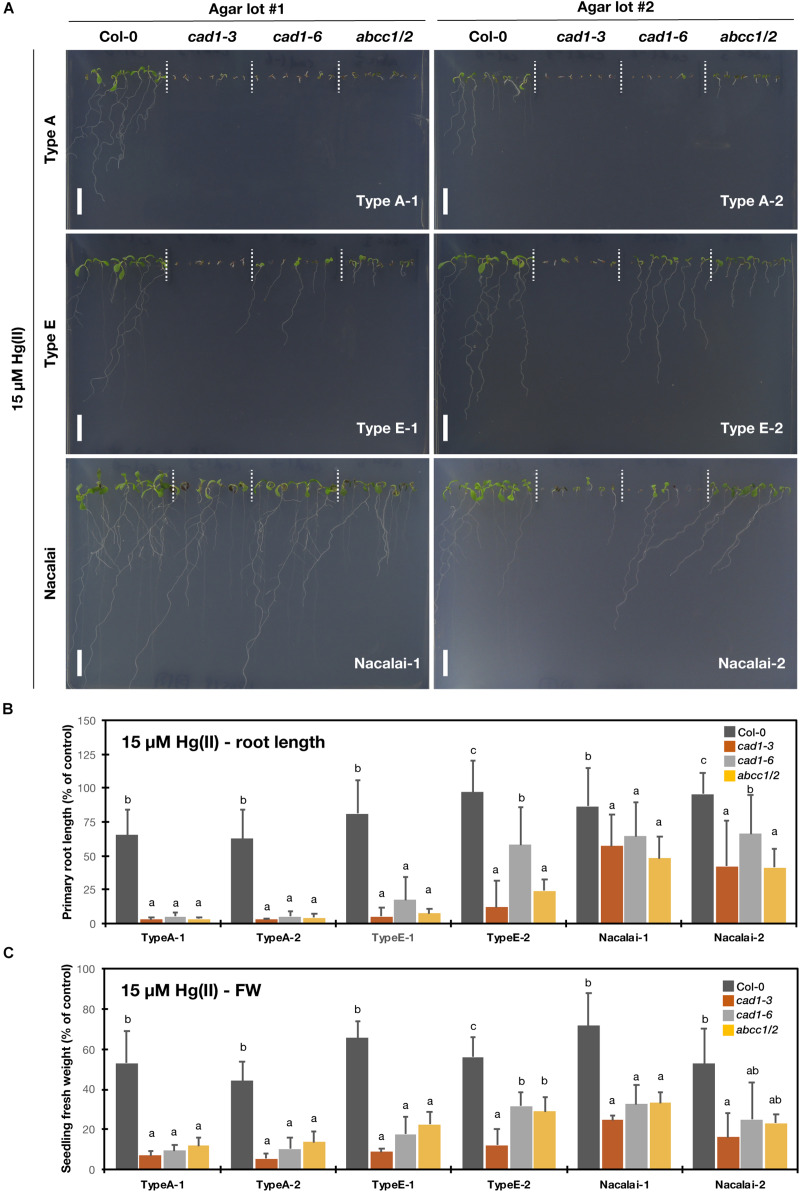
Hg(II)-sensitivity of the phytochelatin-related Arabidopsis mutants on the agar plates prepared with different agar reagents. Three types of agar reagents with two independent lots for each type were tested. Col-0, cad1-3, cad1-6, and abcc1/2 were grown on the agar medium containing 15 μM Hg(II) for 12 days. (A) Phenotypes of Col-0, cad1-3, cad1-6, and abcc1/2. Scale bars = 1 cm. (B,C) Relative primary root length (B) and fresh weight of seedlings (C) of Col-0, cad1-3, cad1-6, and abcc1/2. Values are shown as percentage of each control. Data represent means with SD from at least three independent experiments (n = 13–28 for root length, and n = 3–4 for seedling fresh weight). Means sharing the same letter are not significantly different within each agar reagent (P < 0.05, Tukey’s HSD).